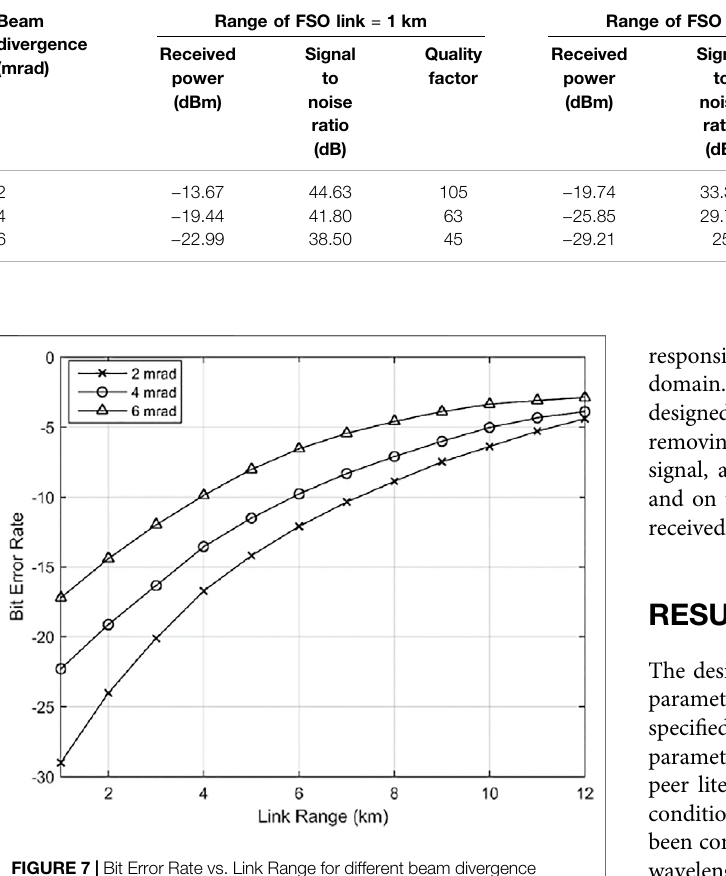
FIGURE 7 | Bit Error Rate vs. Link Range for different beam divergence scenarios.